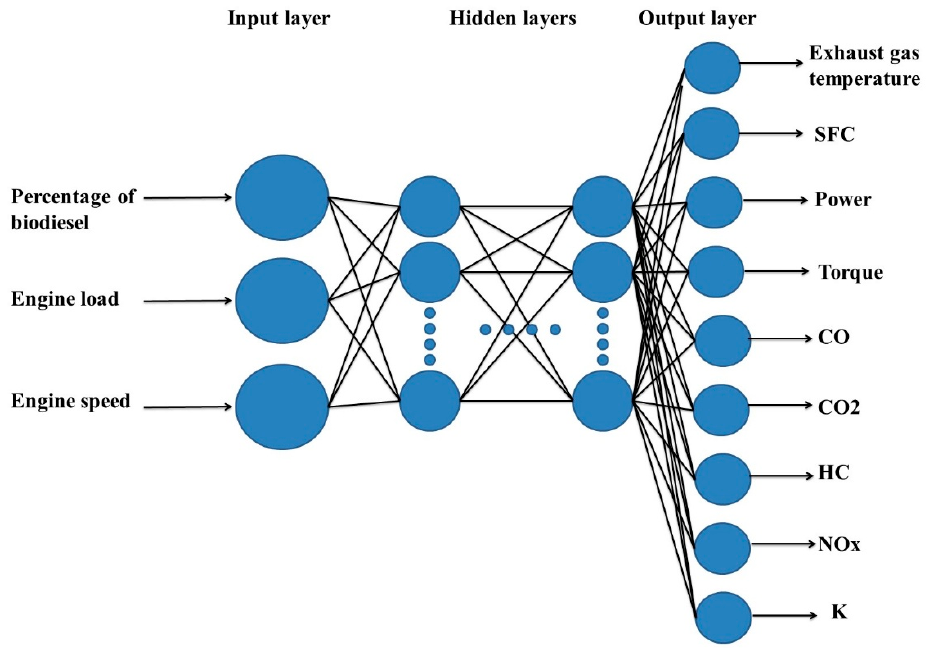
Figure 21. Architecture of the created ANN model.